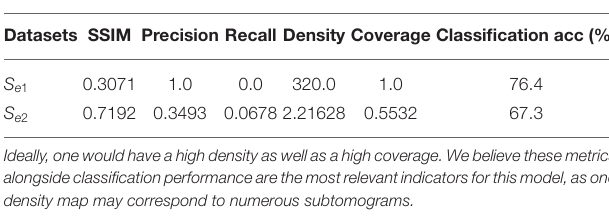
TABLE 2 | Evaluation results via six different